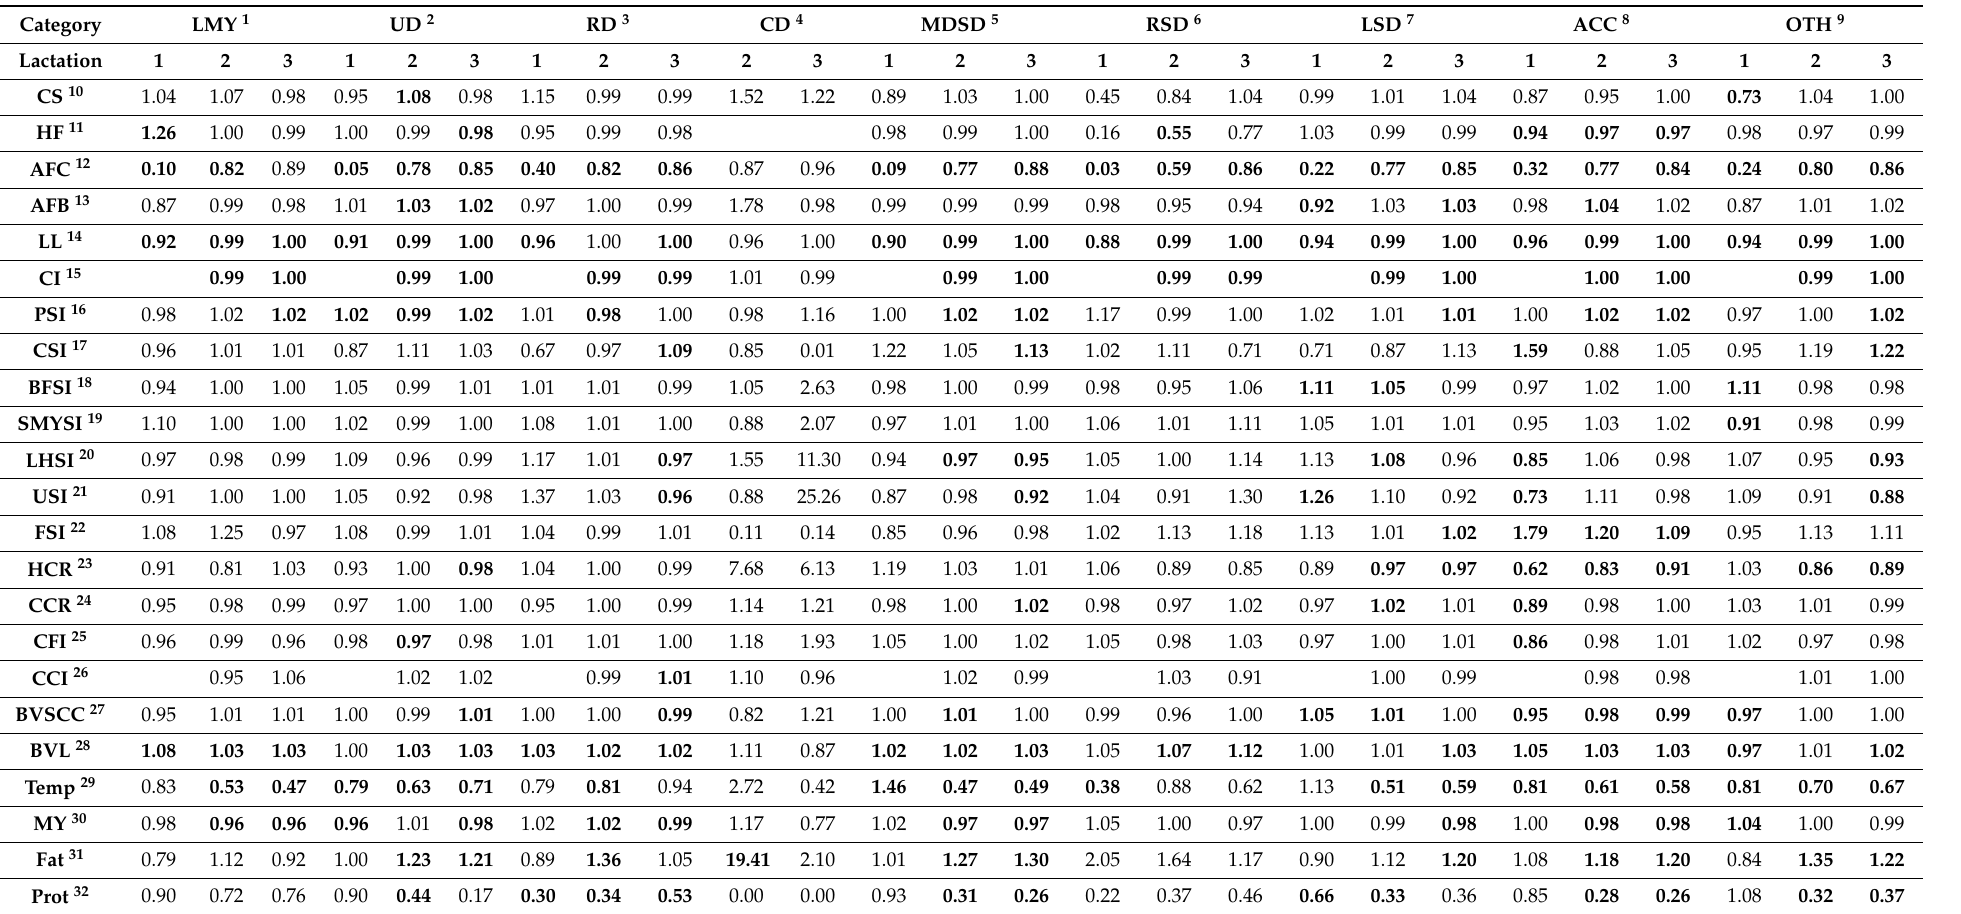
Table 4. HR values for the individual parameters of the Cox proportional hazards model according to culling categories and lactation groups (1—until the first lactation, 2—until the second lactation, 3—until the third lactation; HR values for statistically significant parameters are marked in